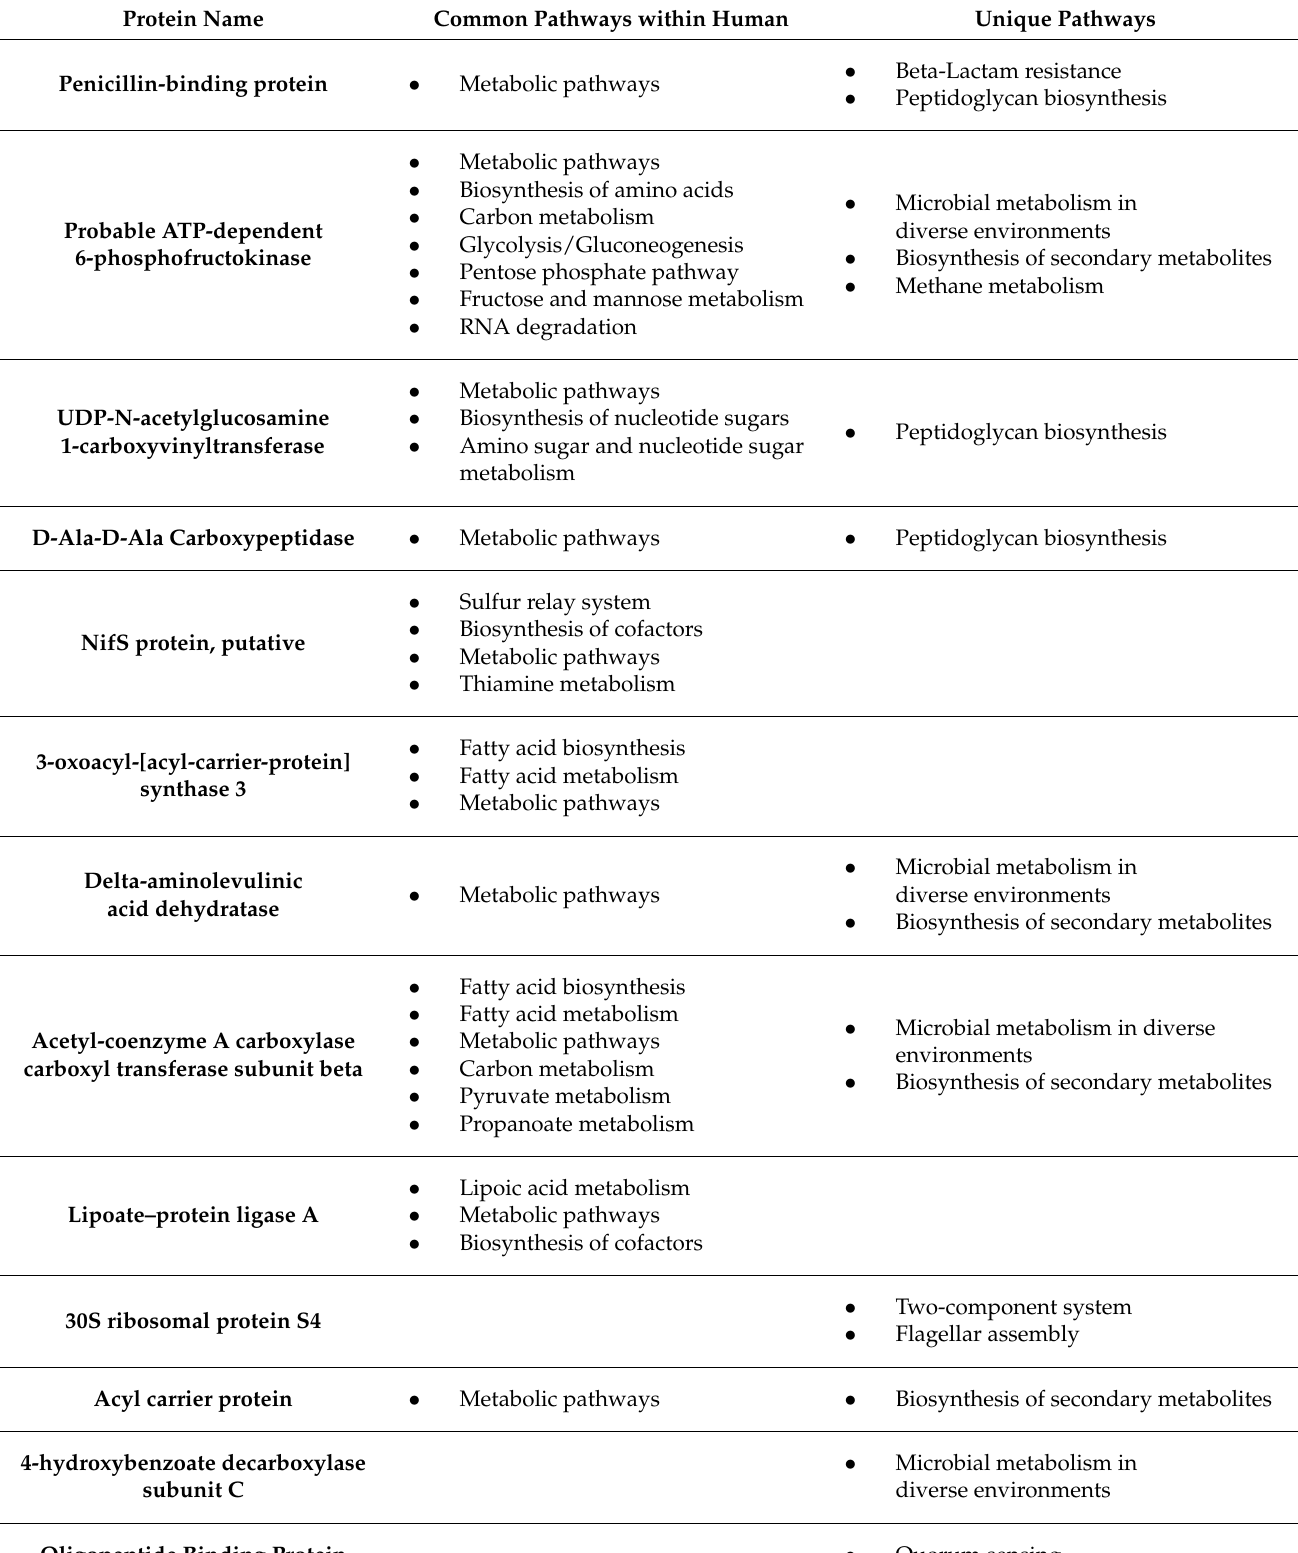
Table 1. Metabolic pathways of predicted